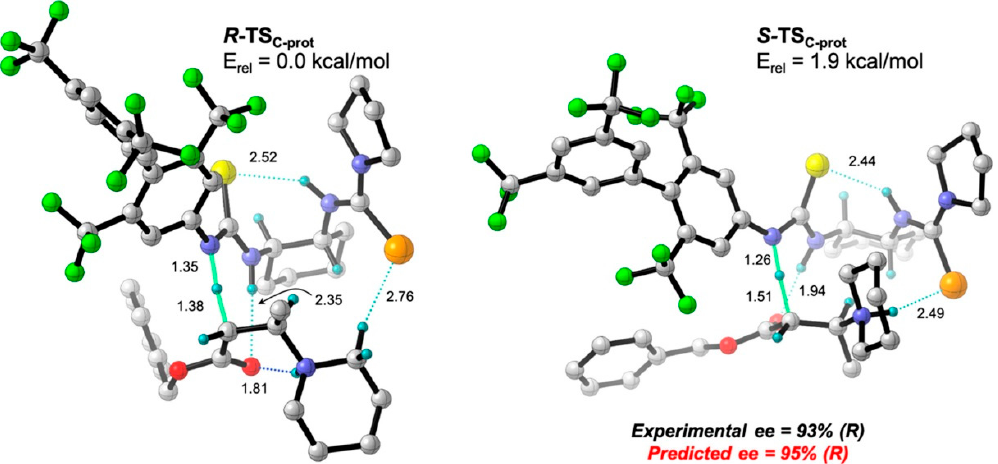
Figure 29. Lowest energy transition structures for C − N bond formation catalyzed by selenourea-thiourea catalyst C22 . Reprinted and adapted from The Journal of the American Chemical Society with permission from the American Chemical Society [63].